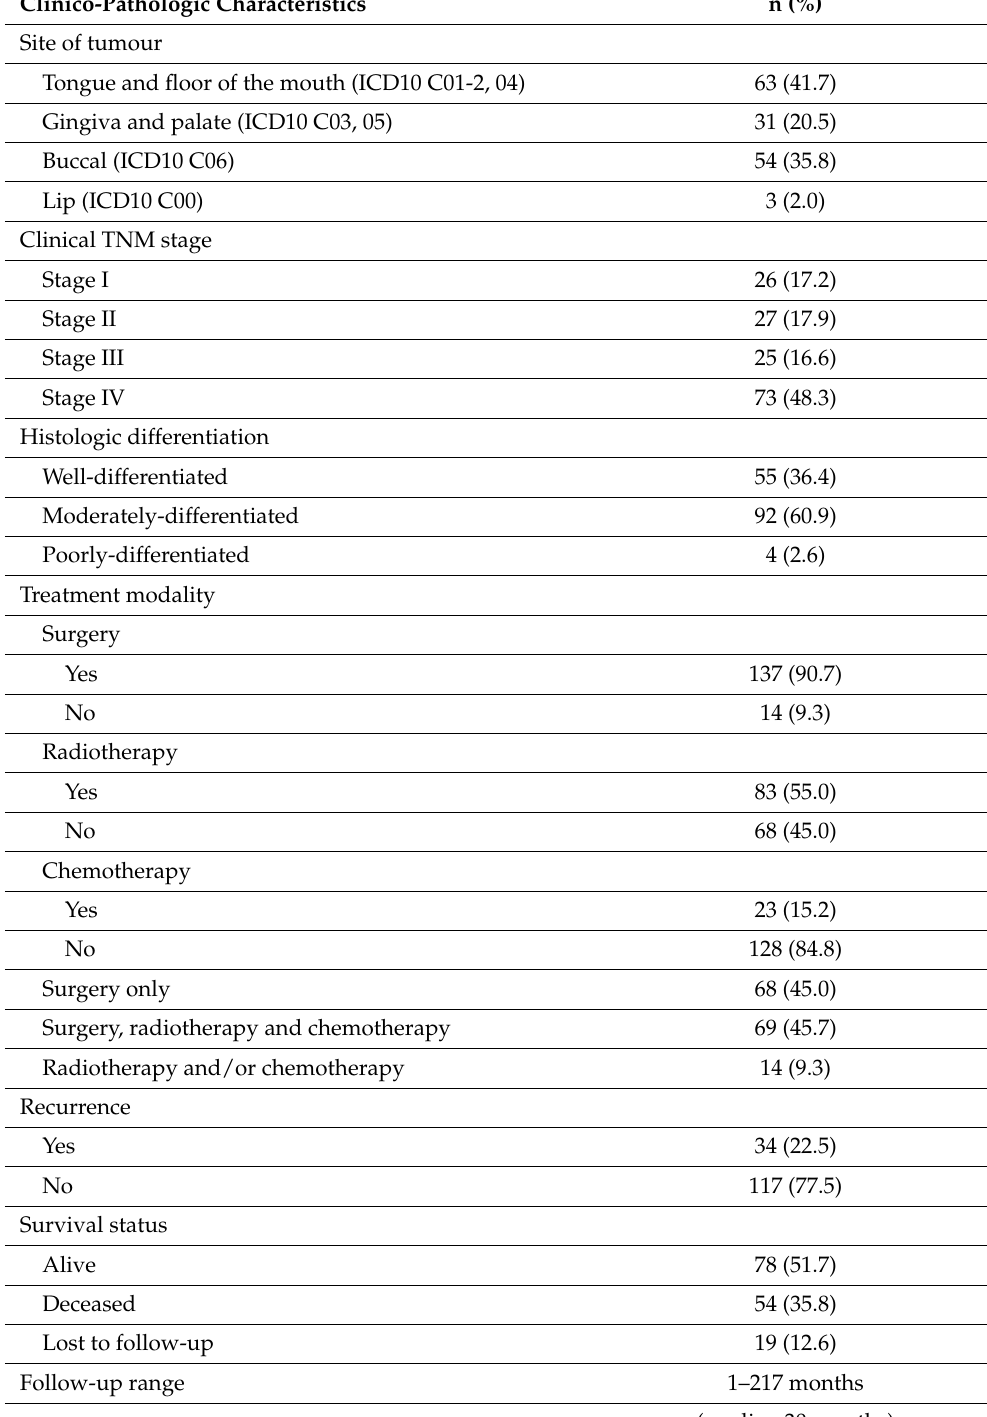
Table 3. Clinico-pathologic characteristics of study population. Clinico-Pathologic